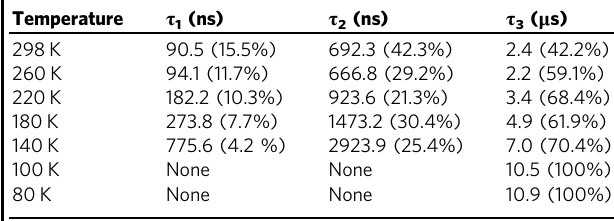
Table 1 Fitted lifetimes of time-resolved PL decays of Au 38 (PET) 26 under different temperatures.